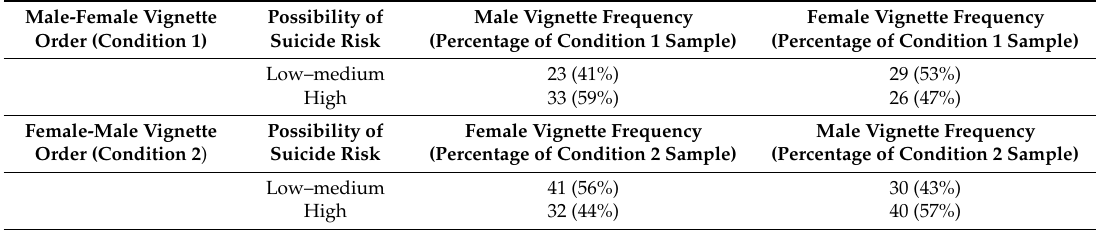
Table 2. Frequencies and percentages of TCWs’ rating of callers’ potential for suicide risk by vignette